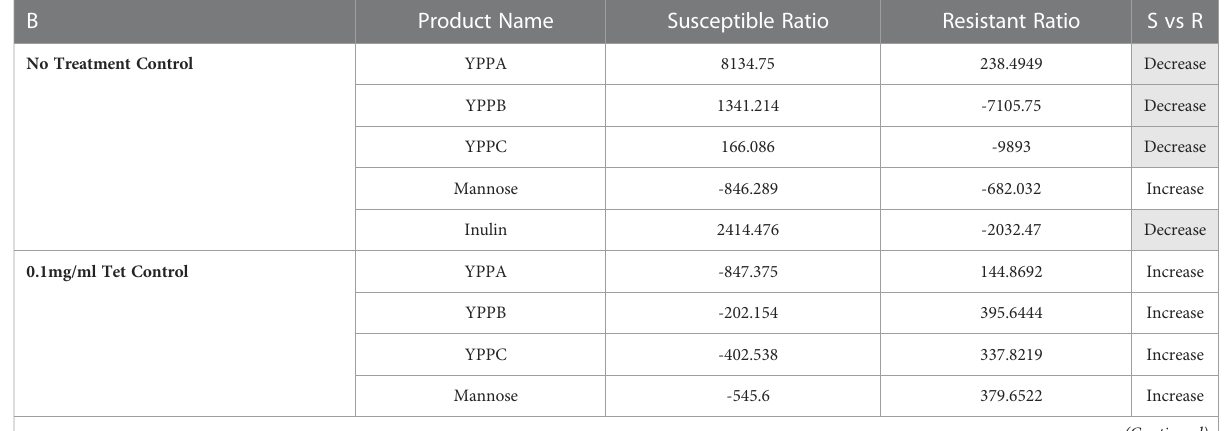
TABLE 2B Ratio of OCR to ECAR for susceptible E. coli (S) versus resistant E. coli (R)